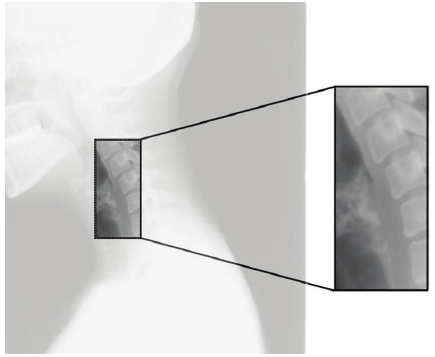
Figure 4: Reduction of the window search.